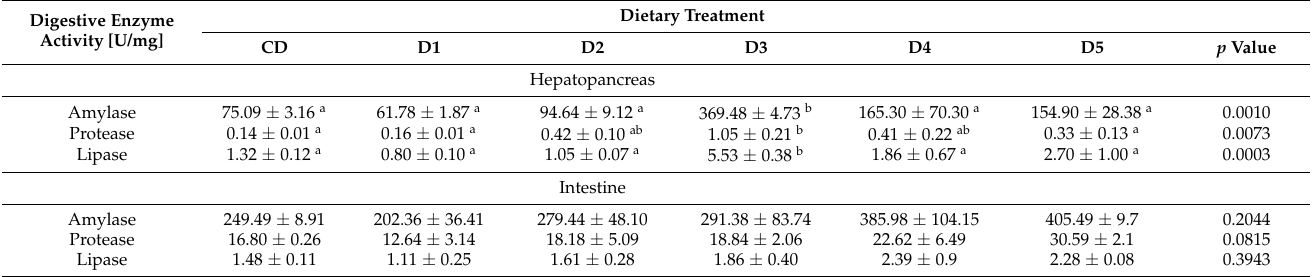
Table 4. Effect of experimental diets on digestive enzyme activity of Litopenaeus vannamei .